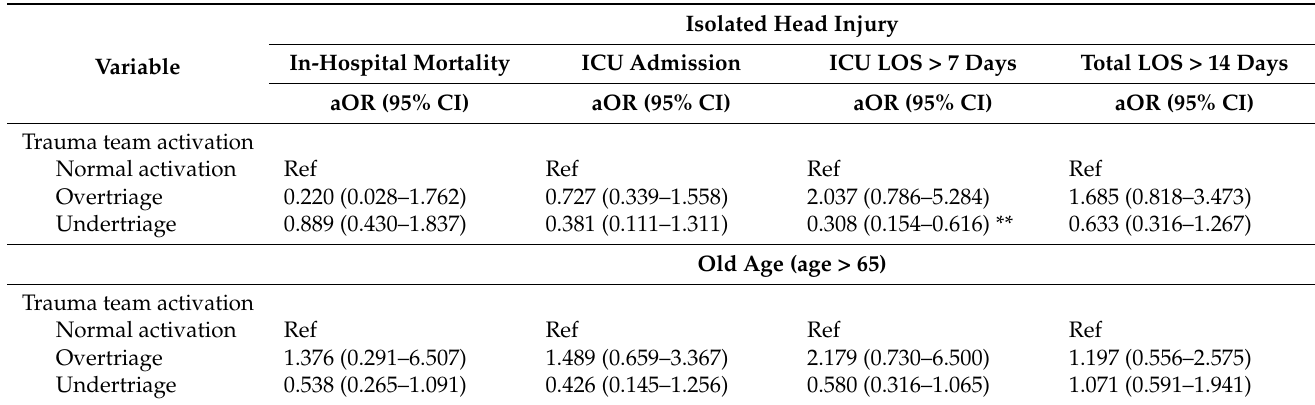
Table 6. Multivariable logistic regression of four major clinical outcomes in isolated TBI and old age